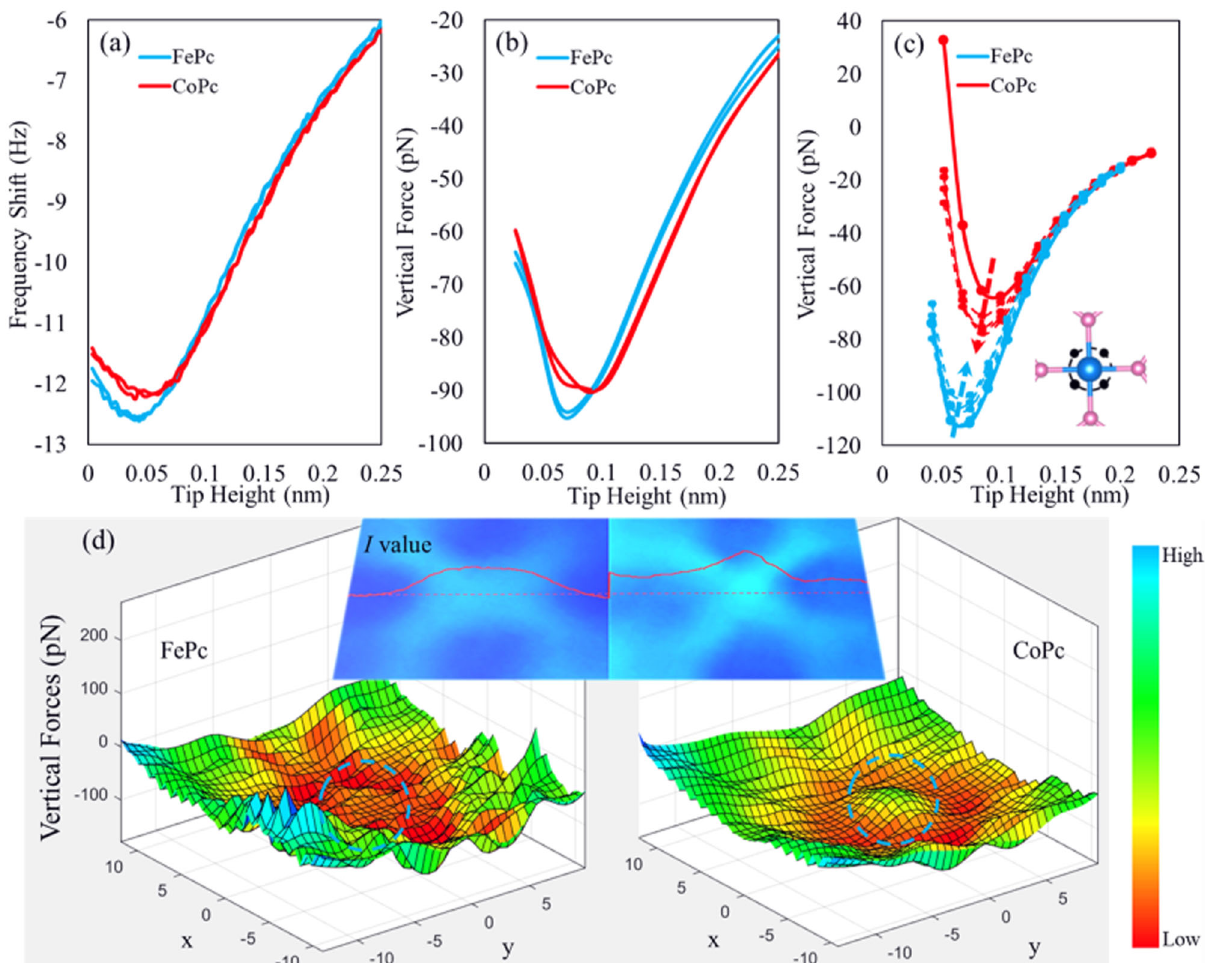
Fig. 3 | Measured and computed forces. a Measured frequency shift (Hz) and b vertical force (pN) acting on the CO tip when it is placed on the top of a center metal atom. c Spin-polarized DFT-predicted vertical forces (pN) acting on the CO tip. In c , the solid curves correspond to a con fi guration where the tip is directly on top of the metal atom. The dashed curves correspond to con fi gurations where the tip is horizontally shifted away from the center by ~60pm as indicated by the four black dots (in the inset) surrounding the metal atom. The dashed arrows indicate